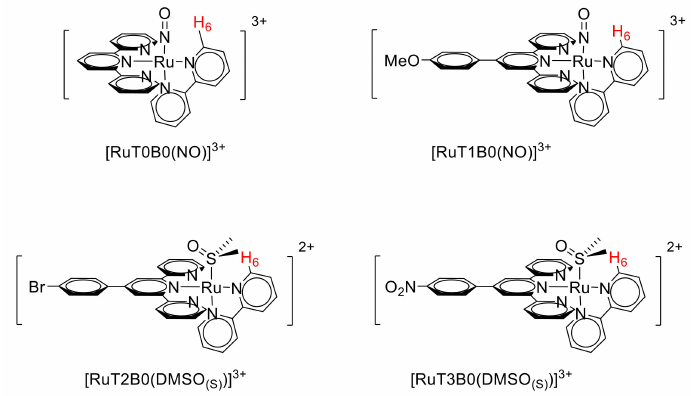
Figure 1. Ruthenium complexes under investigation. Proton H6 used for the NMR characterization is indicated in red color on the bipyridine